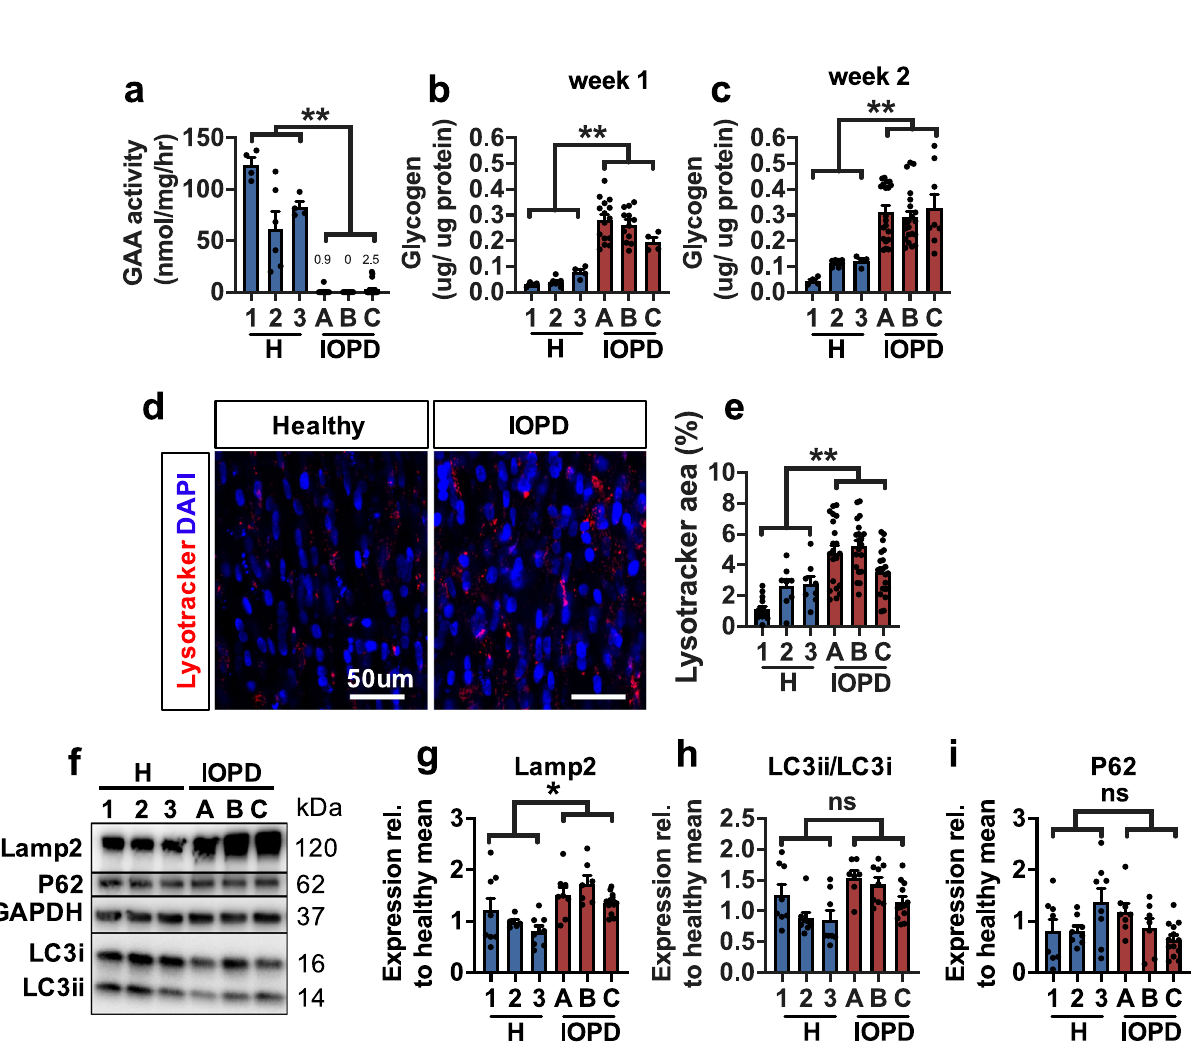
Fig. 2 Biochemical and morphological characteristics of IOPD myobundles. a GAA activity in 3 healthy (1, 2, 3) and 3 IOPD (A, B, C) myobundles ( n = 4 – 21 myobundles per donor). b , c Glycogen content after b 1 week ( n = 4 – 12 myobundles per donor) and c 2 weeks ( n = 4 – 21 myobundles per donor) of 3D differentiation. d , e Representative images of healthy and IOPD myobundles stained live with lysotracker and DAPI at 2 weeks of 3D differentiation ( d ) and corresponding quanti fi cation of percentage of myobundle area positive for lysotracker ( e ) ( n = 8 – 21 myobundles per donor). f – i Representative western blots ( f ) and quanti fi ed protein expression of g Lamp2, h LC3-II/LC3-I ratio, and i p62/SQSTM1 (normalized to GAPDH) ( n = 5 – 13 myobundles per donor). Data: mean ± SEM. * p < 0.05; ** p < 0.01; *** p < 0.001; ns not signi fi and, unlike IOPD myobundles, did not exhibit elevated gly- normalization was performed by cellular (approximated by cogen content (Supplementary Fig. 3b, c). This lack of phe- GAPDH) instead of total myobundle protein (Supplementary notype in LOPD myobundles may be due to the longer disease Fig. 2). We also fabricated functional 3D human myobundles progression timeline in LOPD, and is consistent with the using myoblasts from two patients with late-onset Pompe observation that ~20% of patients with LOPD do not develop disease (LOPD). The LOPD myobundles reduced GAA activity, elevated glycogen 30,31 . yet not as low as IOPD myobundles (Supplementary Fig. 3a)